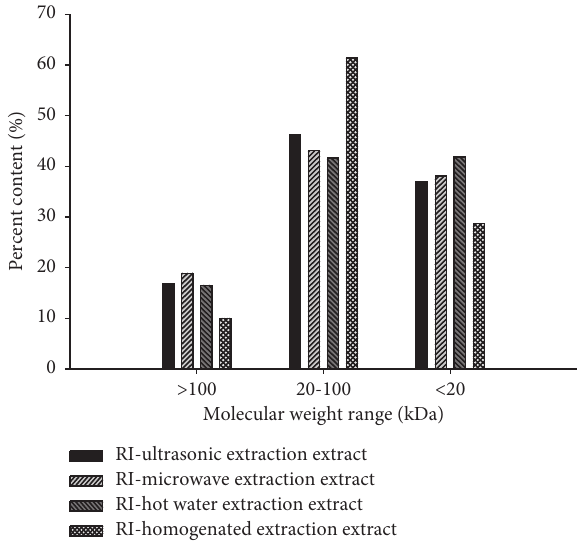
Figure 4: The molecular weight range of the polysaccharides in PNMP extracts produced by three other extraction methods and homogenate extraction method.